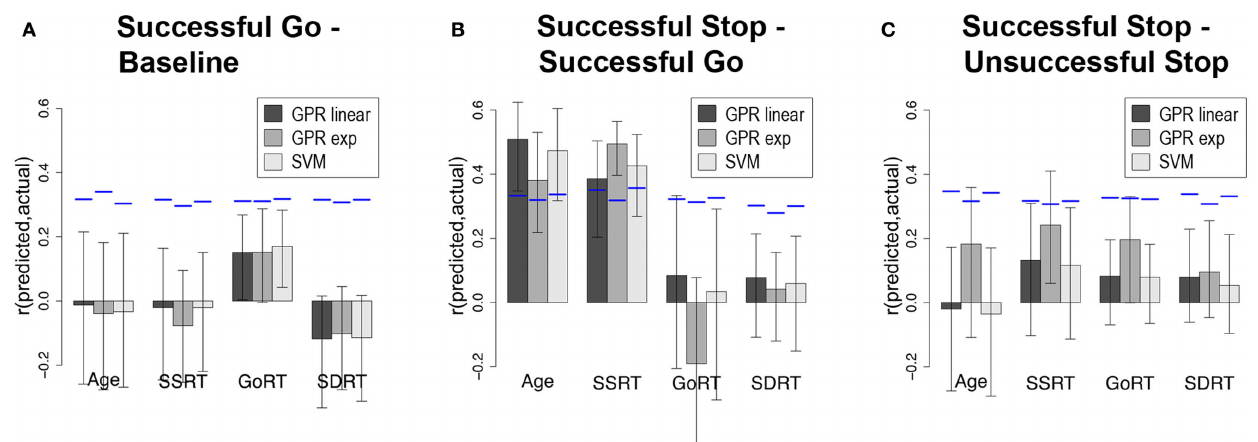
distribution, whereas the error bars depict the 95% confidence interval of correlation values across cross-validation samples. Thus, the blue depicts the threshold for statistical significance against the null hypothesis of zero predictability, whereas the error bars depict the stability of the prediction estimates across samples. Note that only predicted age and SSRT label values during successful stop – successful go are significantly related to actual age and